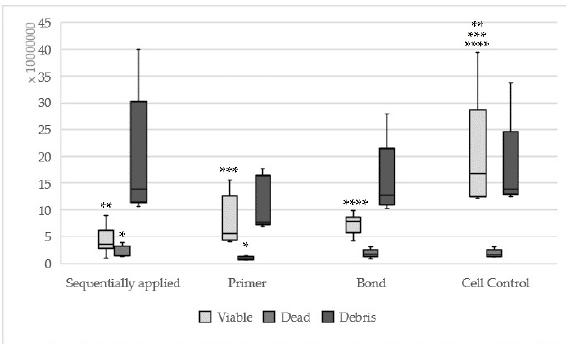
Figure 4. Results of AdheSE sequentially applied, single applied (Primer, Bond) and Cell control; (Sequentially applied vs. AdheSE Primer * viable: p = 0.008; sequentially applied vs. AdheSE Bond ** debris: p = 0.03; same asterisks show significant differnces in the corresponding groups).